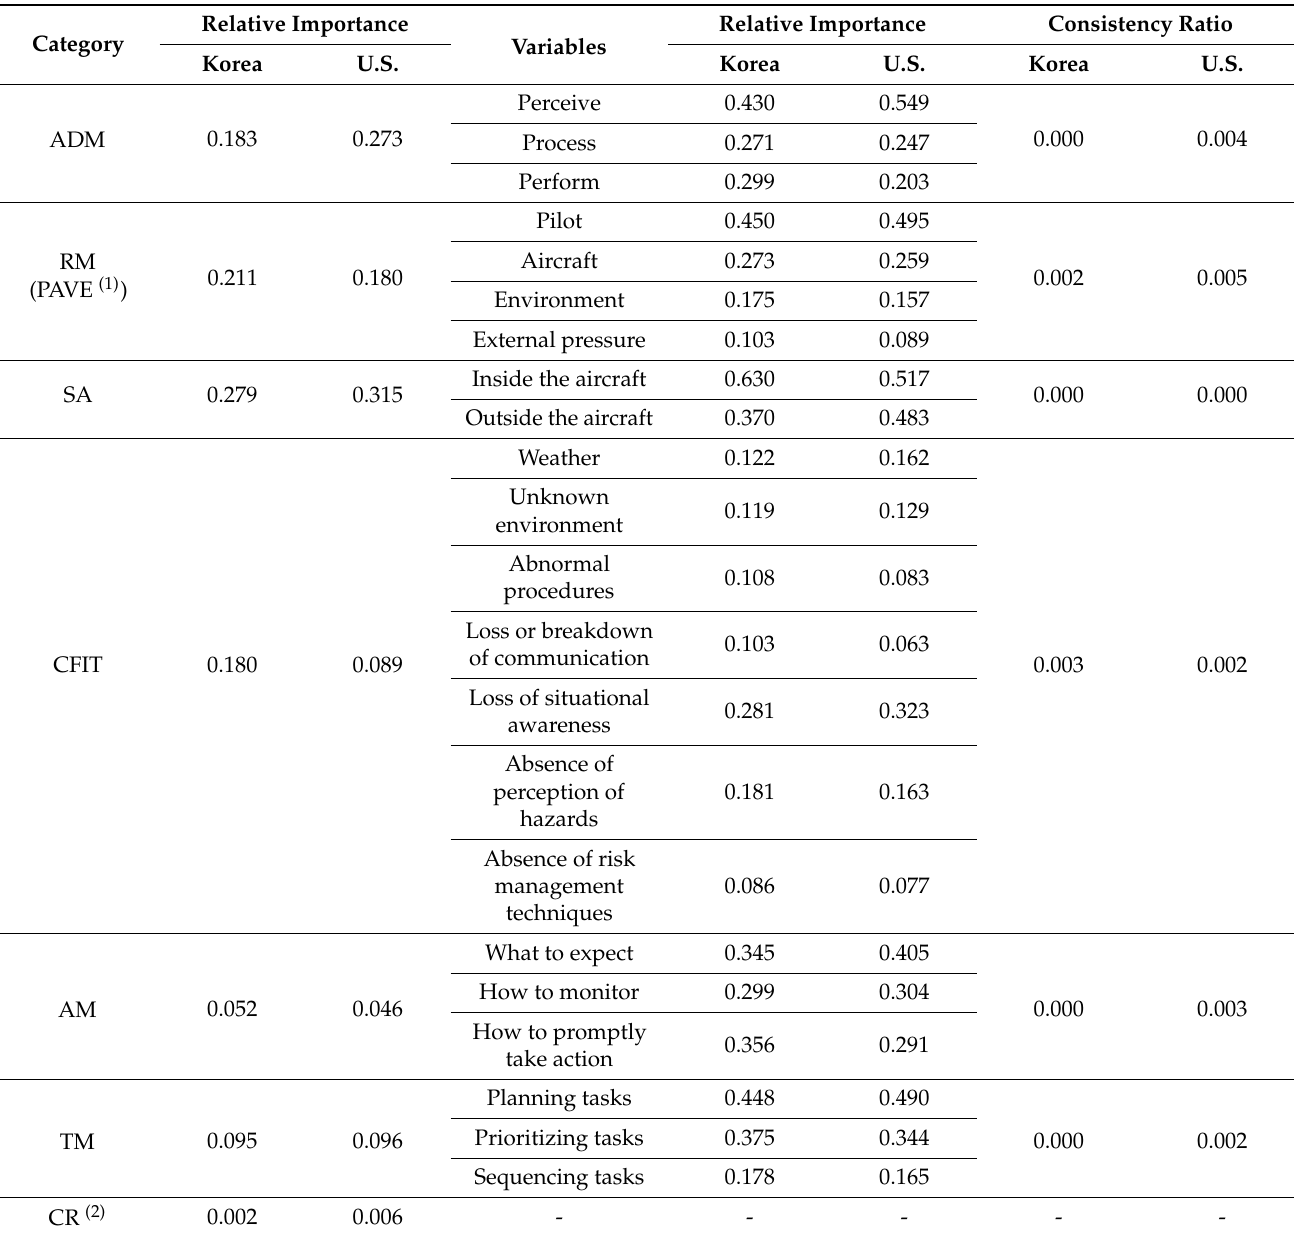
Table 2. Relative Importance of SRM Category and Variables using